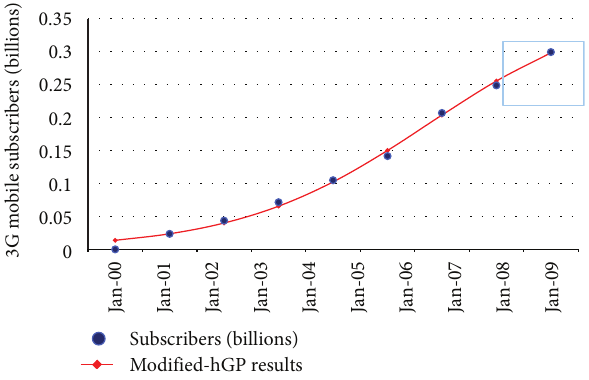
Figure 29: The forecasting performance of the diffusion models (forecast window—2 years ahead) for the number of OECD mobile 3G